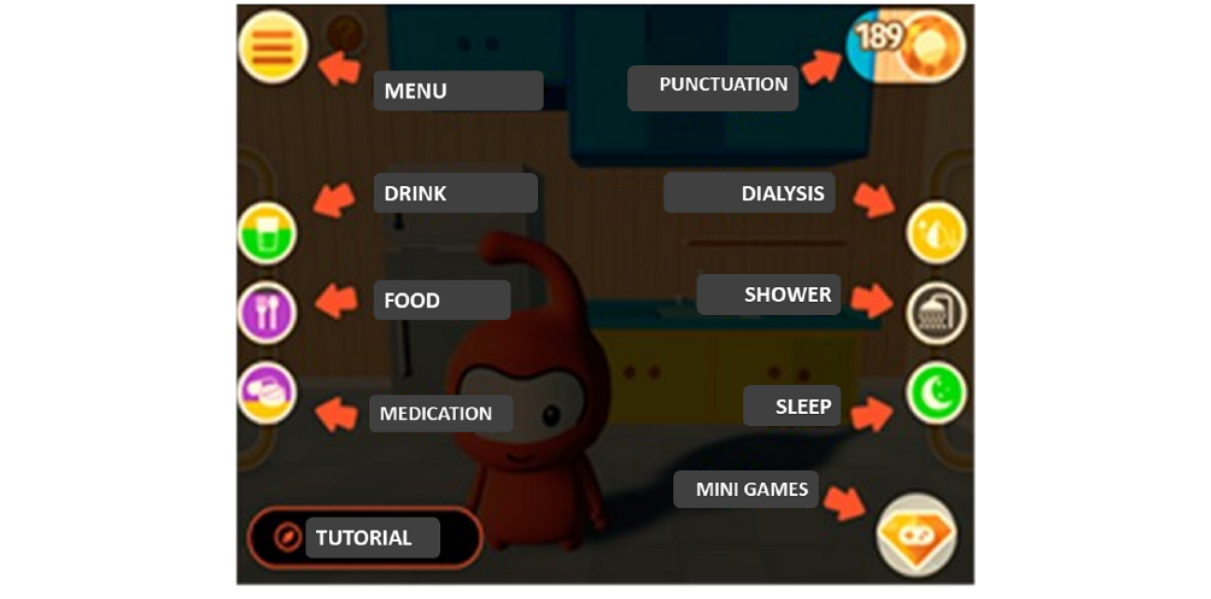
Figure 4. Main app interface and game parameters. Note the icons for accessing the menu, mini games, and tutorial; for viewing points; and suggesting the need for care: thirst (glass with water), hunger (fork and knife), medicine (pills), hemodialysis (blood drop and arrows), hygiene (shower), and fatigue (moon and stars). The icon colors green (normal parameter), yellow (warning sign), purple (lacking care), and black (excessive care) allow combinations where hospitalization conditions are associated with lack or excess of care and the release of points to access bonus mini